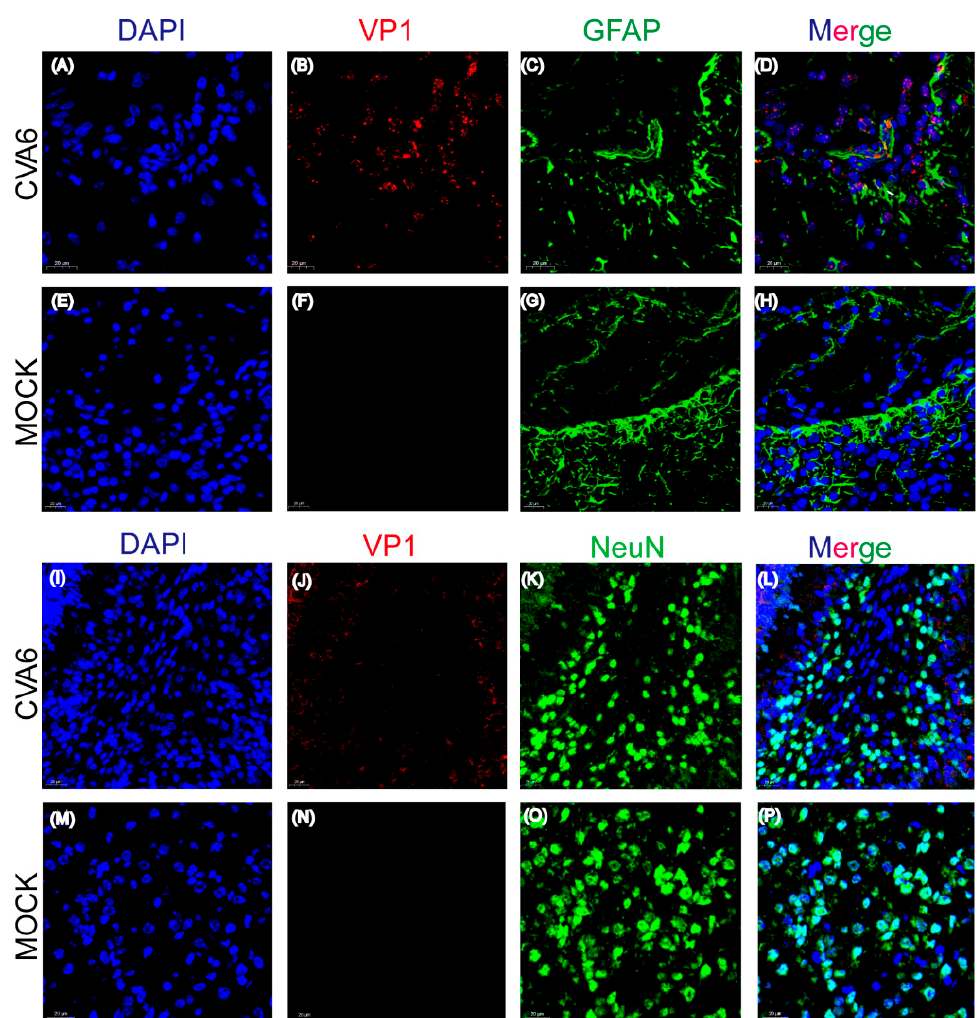
Figure 3. Co-localization of viral antigens with astrocyte marker GFAP in infected brain tissues. Suckling mice were injected with CVA6 or cell culture maintenance medium. Brain tissue sections of suckling mice were fixed and immunostained with DAPI (Blue), VP1 (Red), and astrocyte marker GFAP (Green) ( A – H ); immunostaining with DAPI (Blue), VP1 (Red), and neuron marker NeuN (Green) ( I – P ); Magnifications: ( A , B ) ×400. Scale bar = 20 μ m.